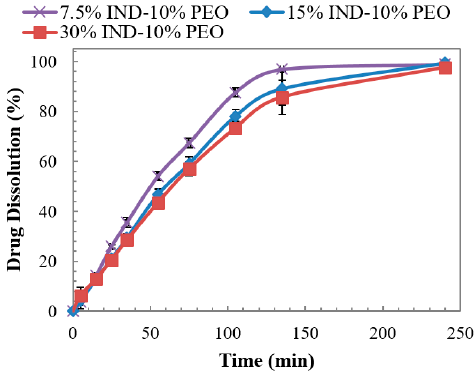
Figure 12. Dissolution of injection moulded tablets of PVPVA-PEO-IND solid dispersions in pH 6.8 dissolution medium.